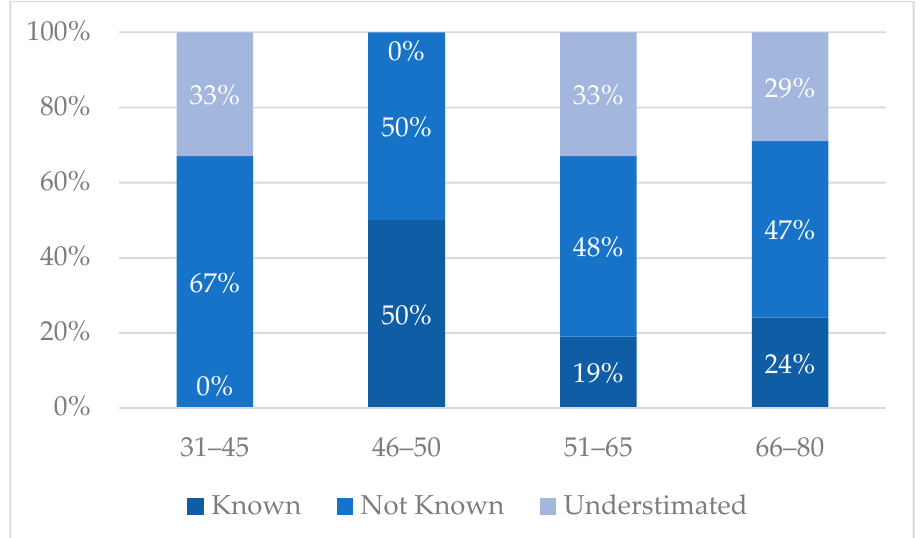
Figure 4. Knowledge of the complications of diabetes.